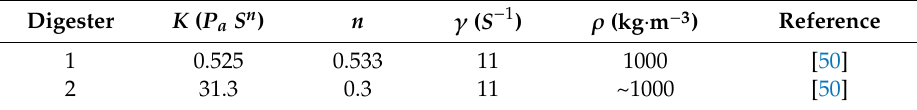
Table 4. Manure physical characteristic for energy